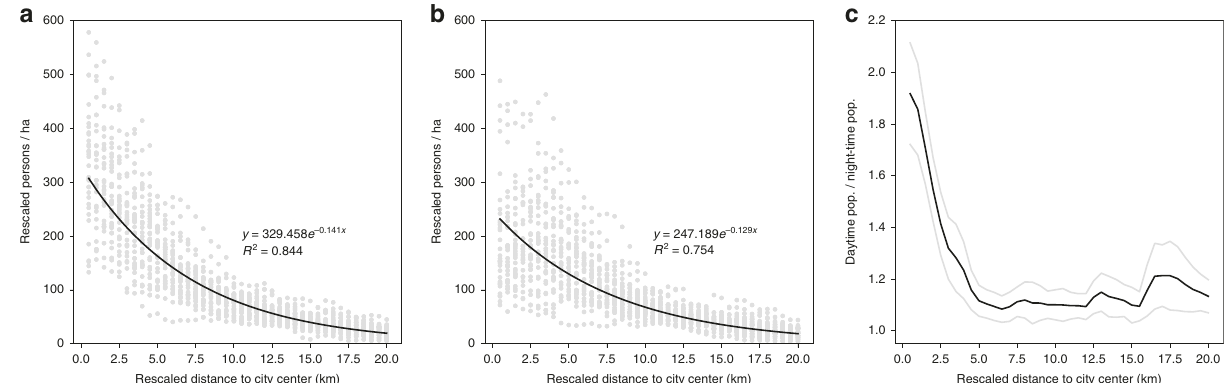
Fig. 3 Concentric population density pro fi les of the largest European Union cities. Average population density for daytime ( a ) and nighttime ( b ), and average ratio between day- and nighttime populations ( c ) for the 34 cities in Europe with a population above 1 million in 2011. Population densities and distance to city center were rescaled as prescribed by Lemoy and Caruso 59 to make the concentric population density pro fi les comparable across cities of different population sizes. Gray dots in a and b represent individual city measurements of population density. Gray lines in c delimit the 95% con fi dence interval of the mean. In a and b , an exponential curve was fi tted to the population density of all the 34 cities, resulting in a R 2 of 0.844 and 0.754, with n = 1360 (34 cities × 40 concentric ring measurements) and p -value < 0.0001, for daytime and nighttime, respectively. Source data are provided as a Source Data spreadsheet fi